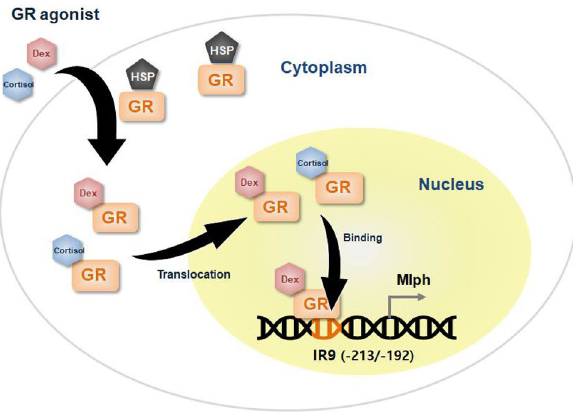
Figure 7. Scheme of GR regulation on Mlph gene